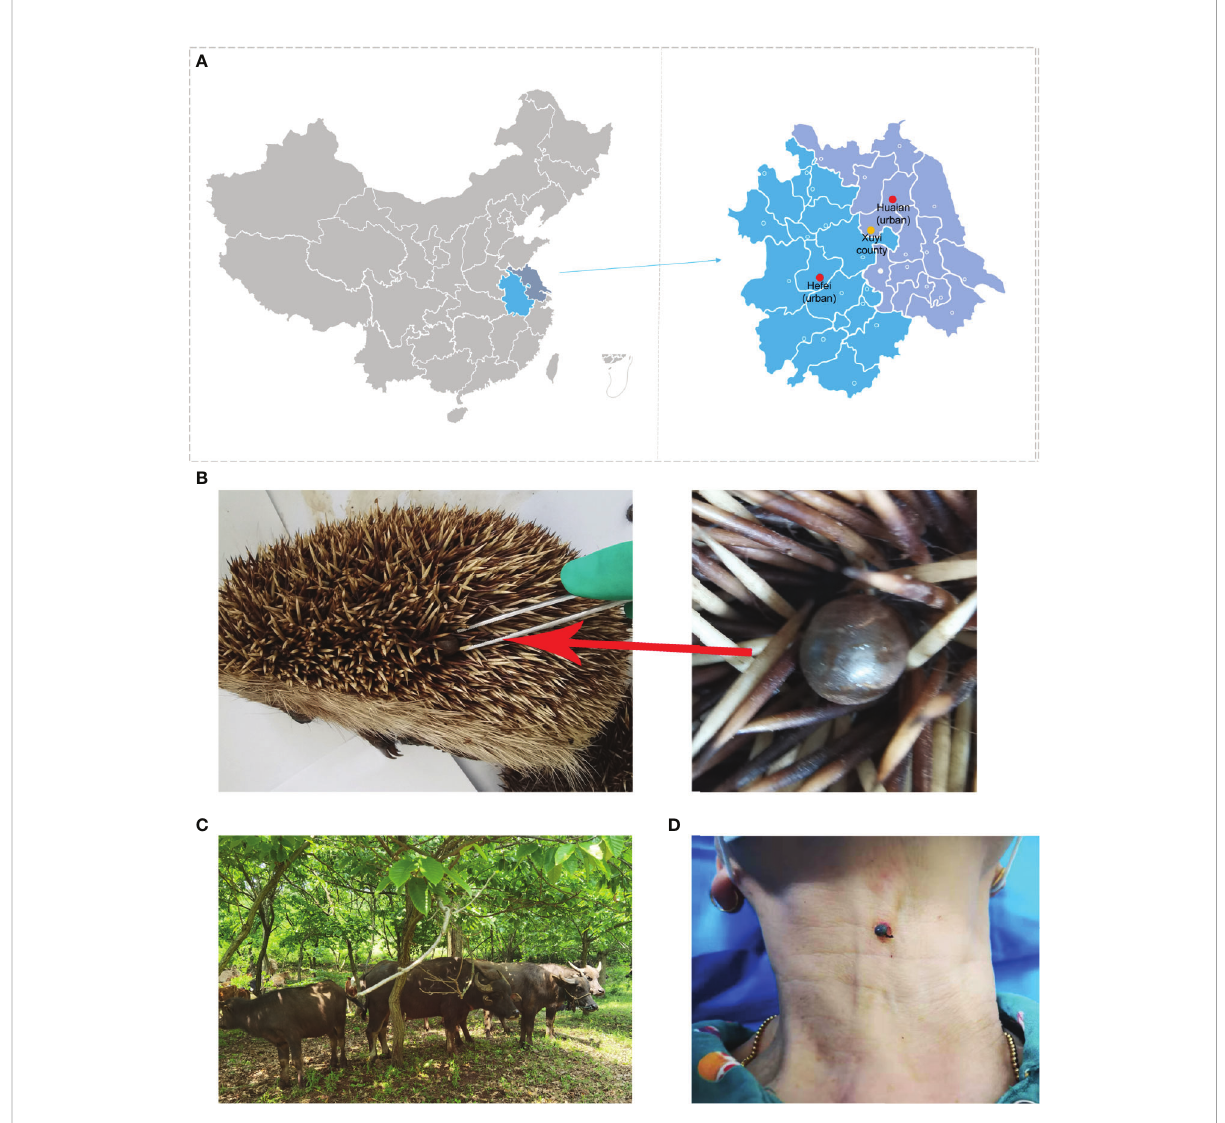
FIGURE 1 Sample collection sites and the observed tick hosts. (A) Locations of tick (yellow dot) and sera (red and yellow dots) collection sites; (B) a parasitic tick collected from an already dead hedgehog; (C) bovine hosts for tick collections; (D) a farmer bitten by a tick observed during our sample